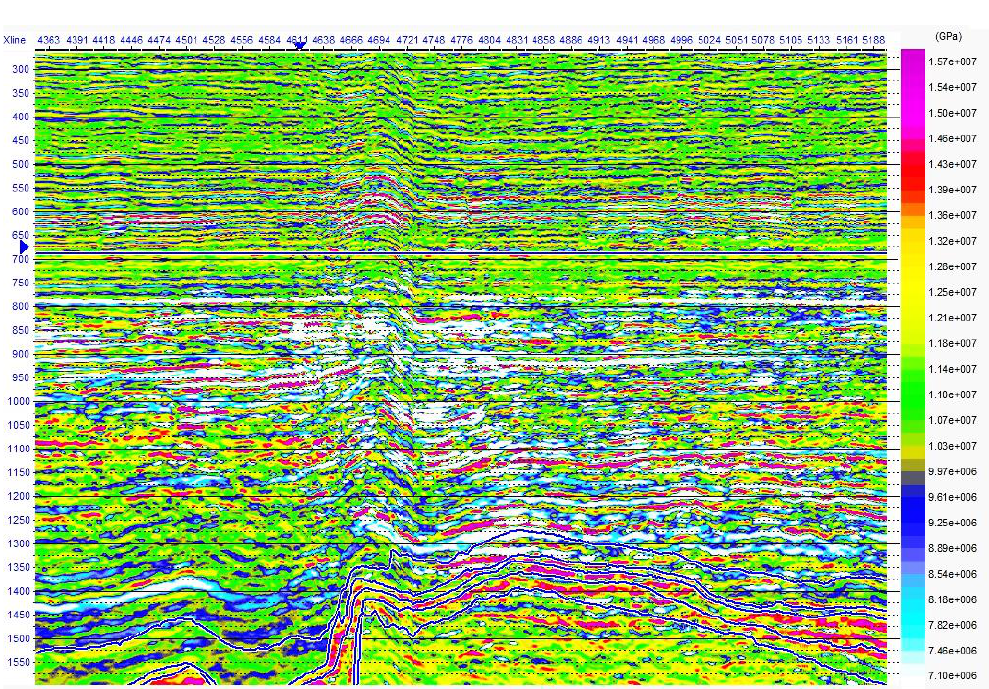
Figure 6. Illustrates the lame modulus of the subsurface layers of reservoir block calculated from the seismic inversion.